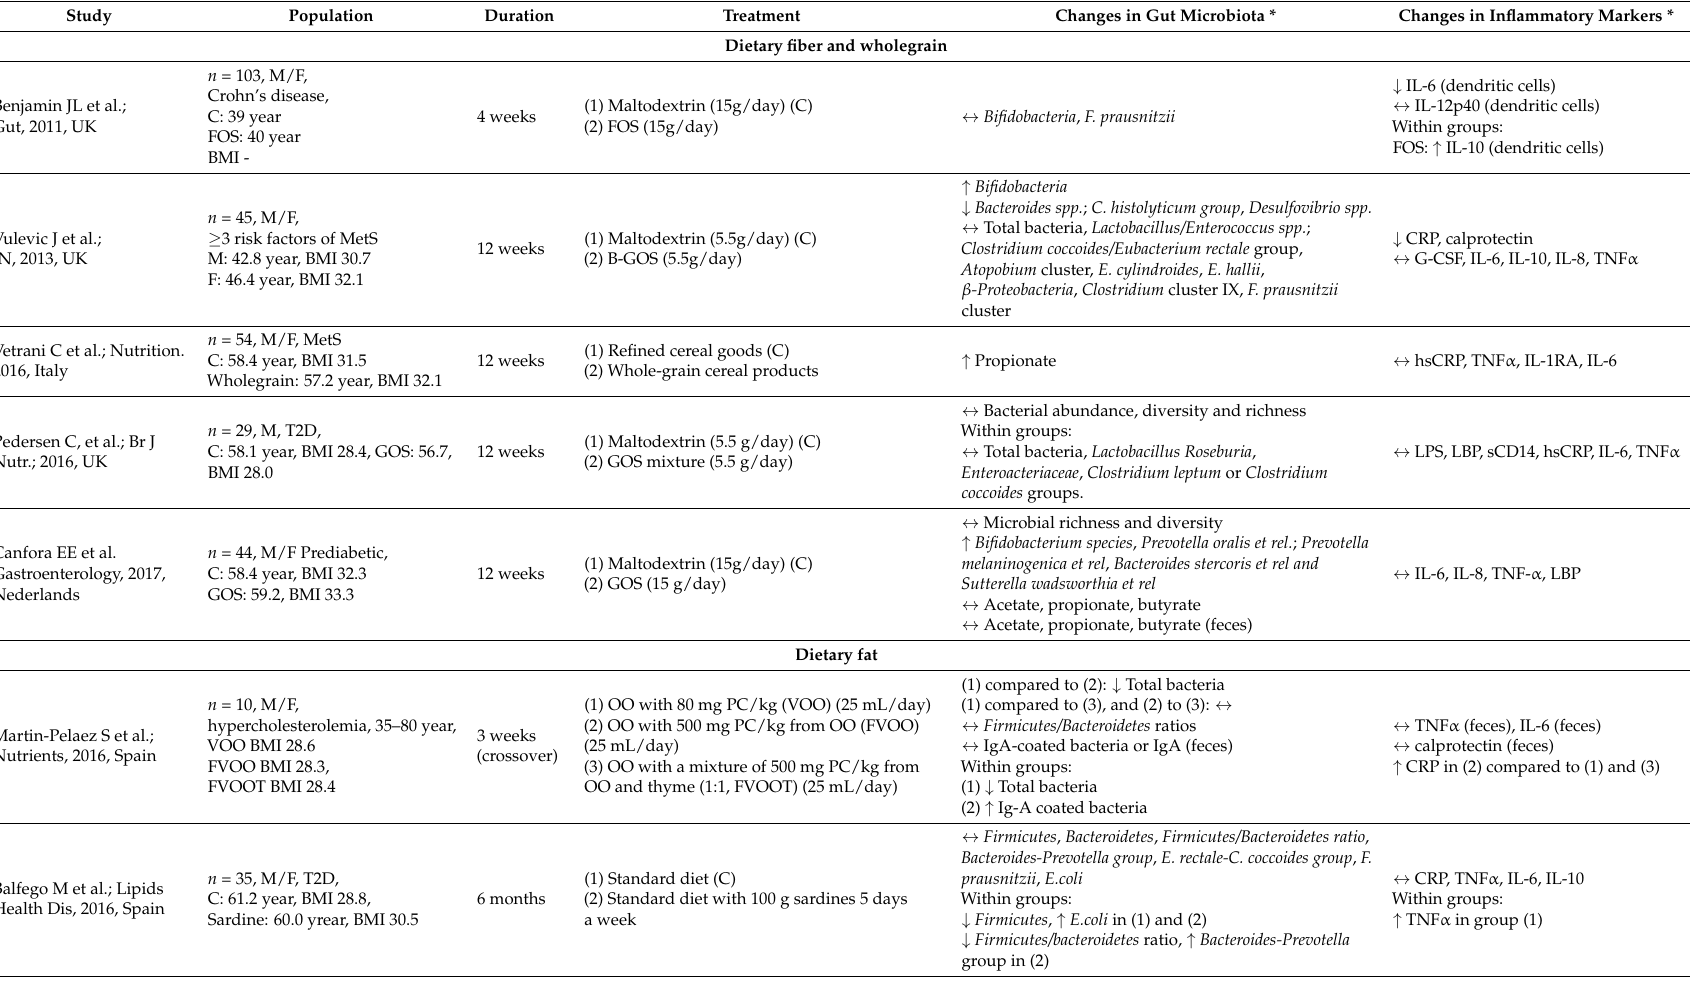
Table 3. Dietary intervention studies evaluating changes in gut microbiota composition and inflammatory markers in children and adults with chronic diseases or metabolic abnormalities.